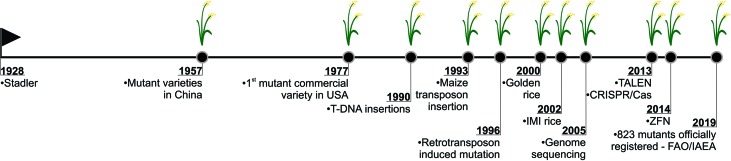
History of mutation induction in rice. Stadler’s pioneering study in inducing mutation using X-ray in barley, maize and wheat (Stadler, 1928; Stadler 1930), demonstrated the possibility in creating genetic variability through mutagenesis. It began a new era where it was possible to apply this tool in the most diverse organisms. The development of the first rice mutant in China, in 1957 (ISAAA, 2019), marks one of the important milestones in the rice mutation history. In USA (1977), the first commercial mutant variety of rice was approved (Rutger et al., 1977). After, the insertion and expression of T-DNA in rice was also reported (Raineri et al., 1990). In 1993, the autonomous element Ac, a component of the maize transposon system, was inserted into the rice genome (Shimamoto et al., 1993). In 1996, the use of retrotransposons to induce mutations in rice was reported (Hirochika et al., 1996). In 2002, one of the rice mutants that revolutionized agriculture was developed in USA. Imidazolinone herbicide-resistant rice cultivars are applied in invasive red rice control (reviewed in Sudianto et al., 2013). In 2002, draft genome sequences of the japonica Nipponbare (Goff et al., 2002) and indica 9311 (Yu et al., 2002) first appeared. In 2005, the map-based complete rice genome sequence was published, becoming the gold standard of crop genomes (IRGSP, 2005). Recently, genome editing technologies have been widely used in various organisms, including plants. The first techniques applied to rice mutagenesis used a non-specific nuclease (Fok I) associated to a DNA-specific domain, comprehend the TALEN (Transcription-like effectors nucleases) (Li et al., 2012; Shan et al., 2013) and ZFN (Zinc-finger nucleases) (Cantos et al., 2014; Jung et al., 2018). CRISPR/Cas system has been widely used to induce targeted genomic editing and has been applied in rice since 2013 (Shan et al., 2013; Jiang et al., 2013, Miao et al., 2013; Feng et al., 2013; Shan et al., 2014). Nowadays, according to FAO/IAEA records, 823 rice mutants have been officially registered since the first genotype developed in China in 1957.